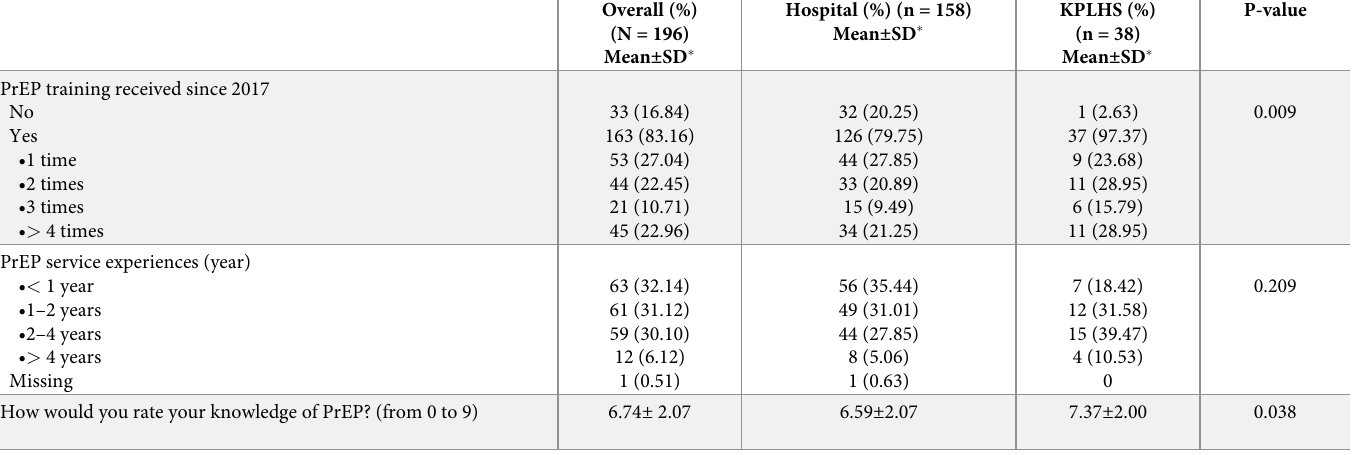
Table 2. Experiences in PrEP services and knowledge of